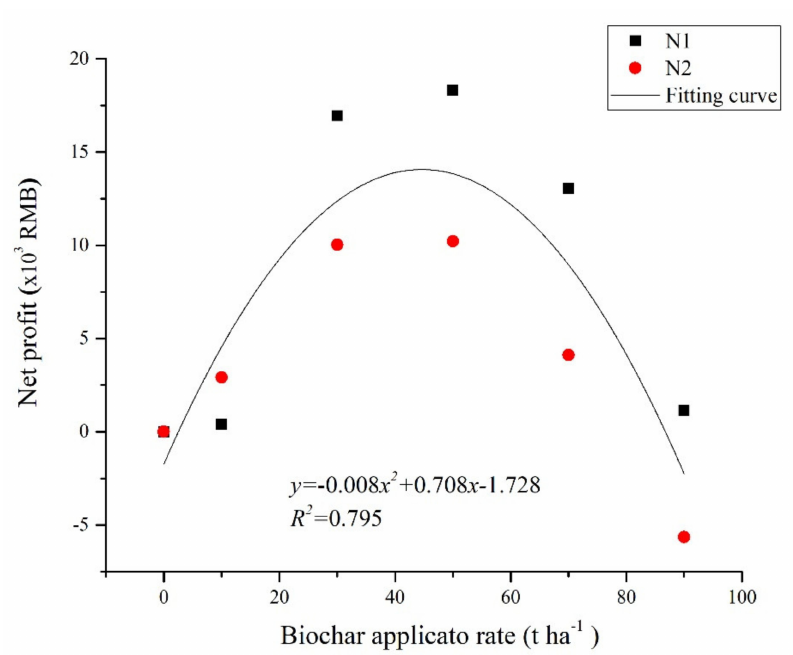
Figure 7. The two-season total net profit varied with the amount of biochar (C0, C10, C30, C50, C70, or C90) and the N fertiliser treatments (N1 and